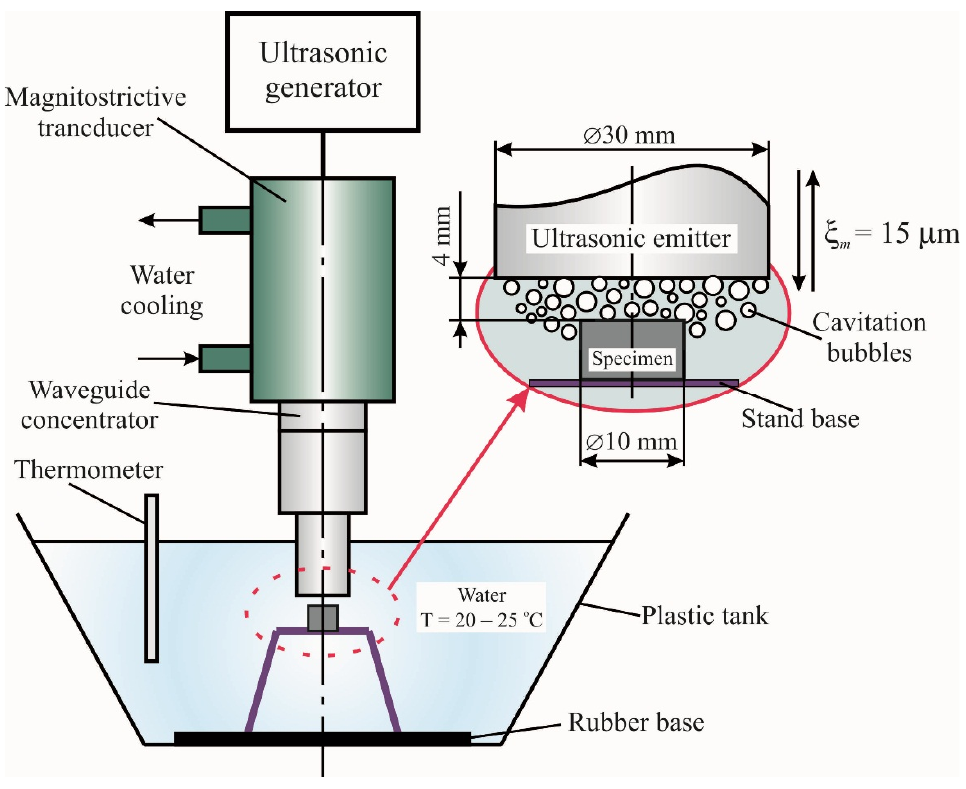
Figure 1. Ultrasonic treatment